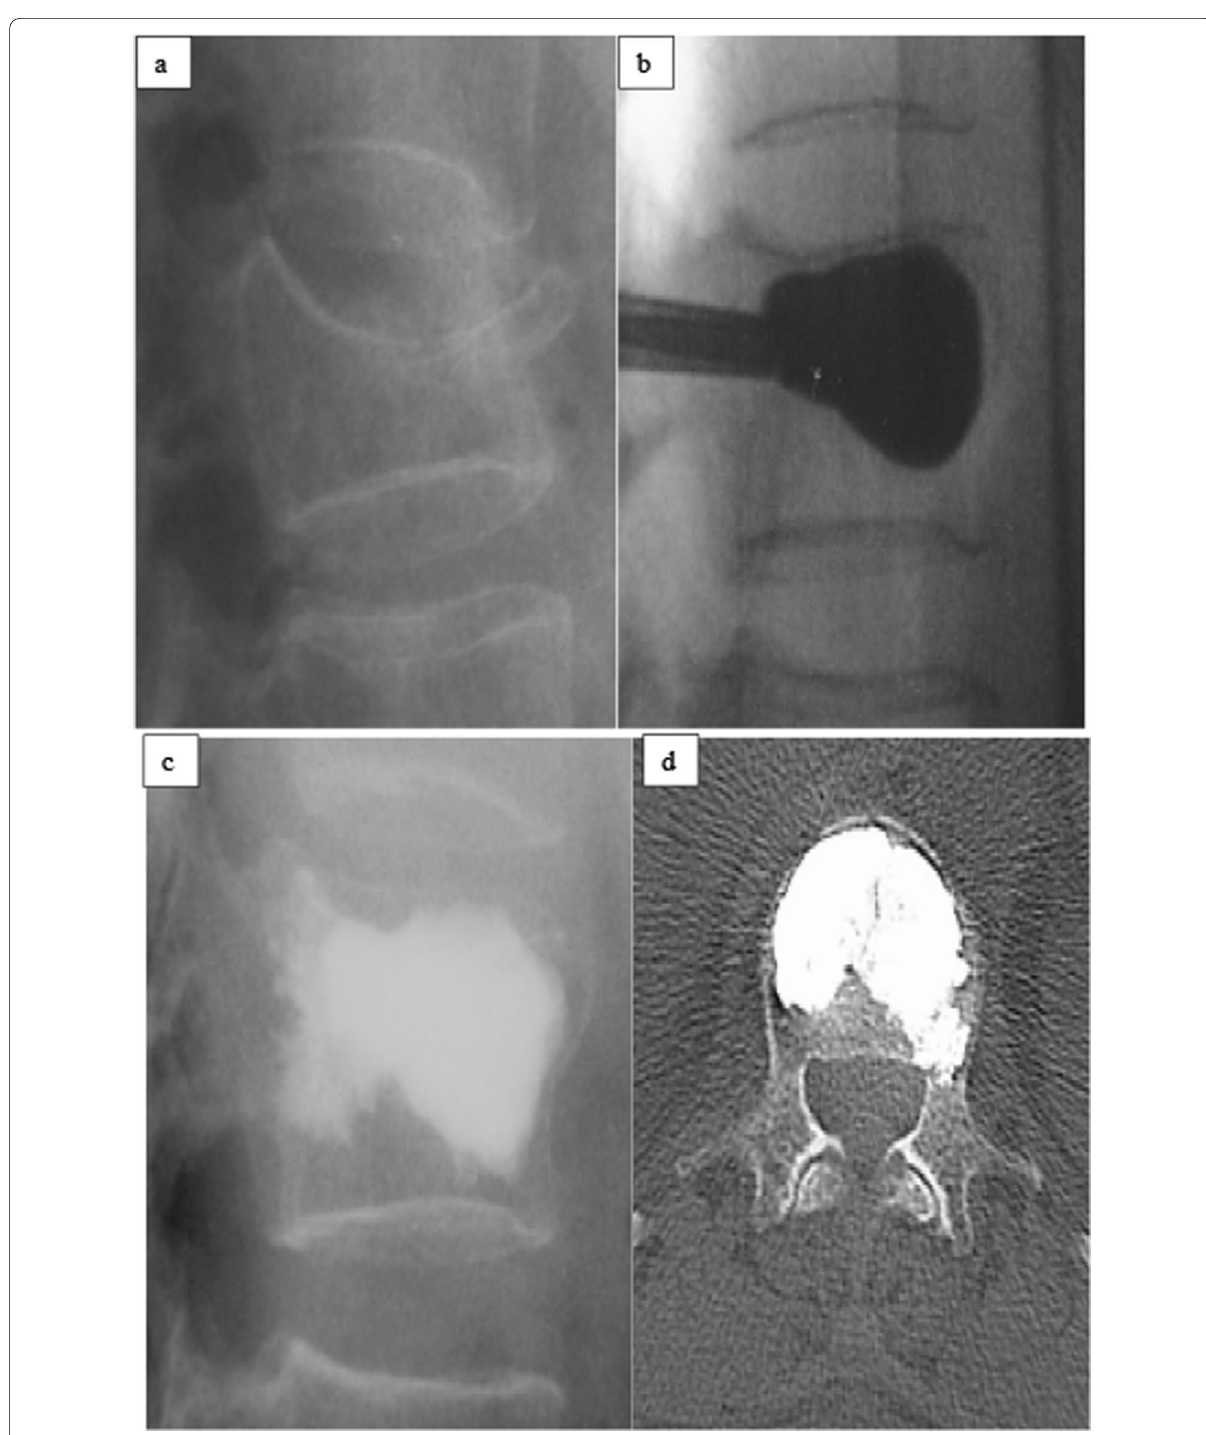
Fig. 1 Kyphoplasty technique: lateral X‑ray: a vertebral collapse; b balloon inflation and progressive injection of radiopaque cement; c post‑kyphoplasty X‑ray, d post‑kyphoplasty CT scan in axial